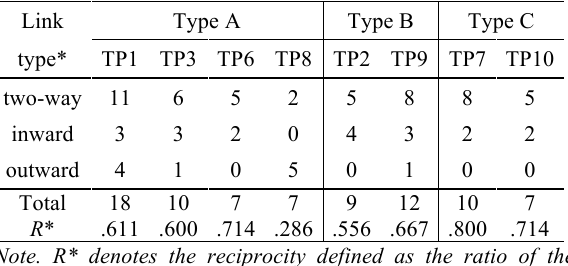
Number of neighbors of core nodes by type of link.